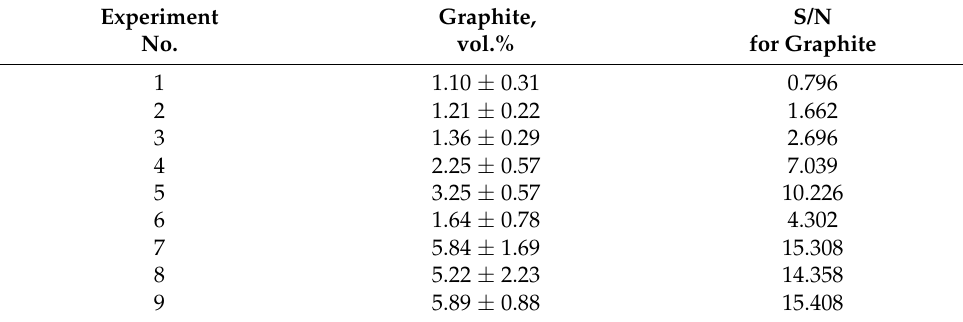
Table 6. Results of the Taguchi experiment for graphite content. SS — sum of squares, DOF — degree of freedom, V — variance, P, % — contribution of parameter.